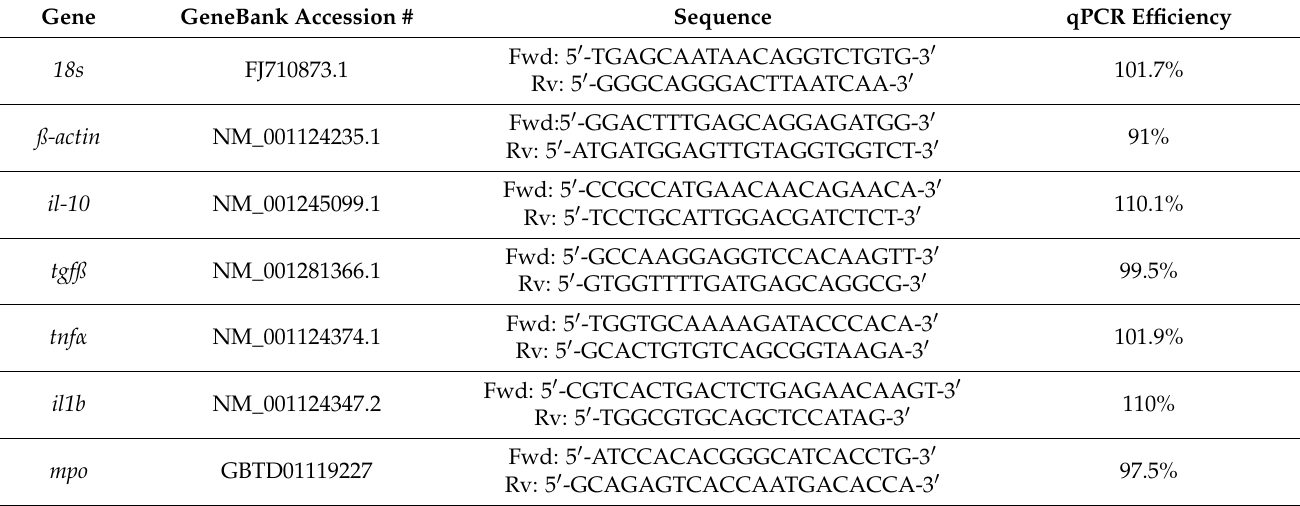
Table 1. Sequence and qPCR efficiency for each primer used for gene expression analysis by real-time